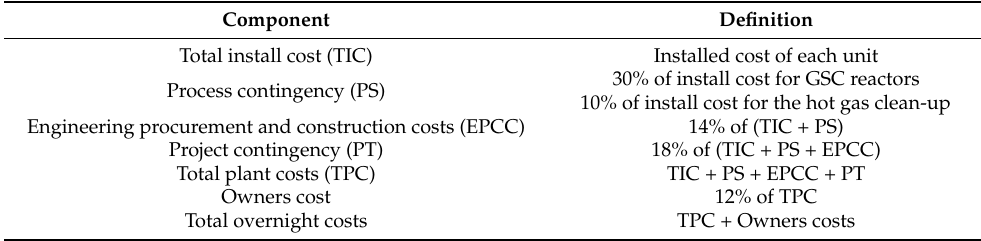
Table 3. Estimation methodology for the total overnight cost of the plant.